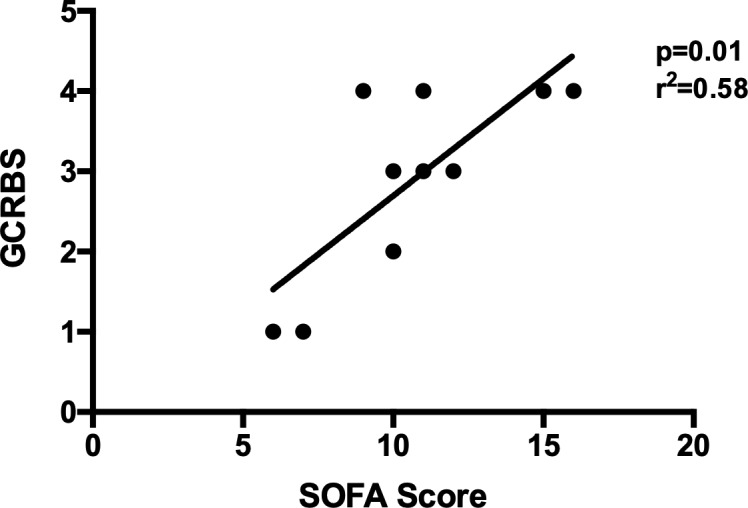
Malarial and non-malarial severity scores.A positive linear regression was found between Sequential Organ Failure Assessment score (SOFA) and GCRBS Score (Glasgow coma scale, Creatinine, Respiratory rate, Bilirubin, Systolic blood pressure).